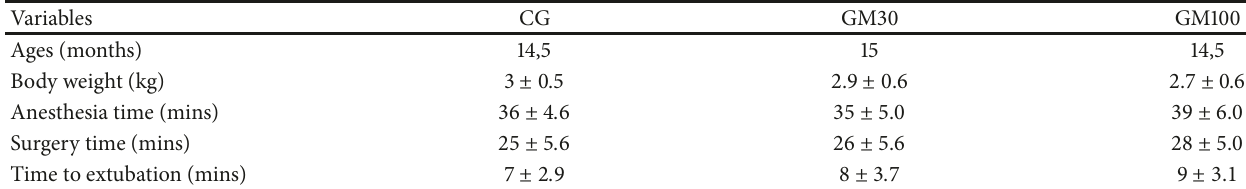
Table 1: Body weight, anesthesia and surgery time, and time to extubation in cats undergoing ovariohysterectomy. Variables CG GM30 GM100 Ages (months) Body weight (kg) Surgery time